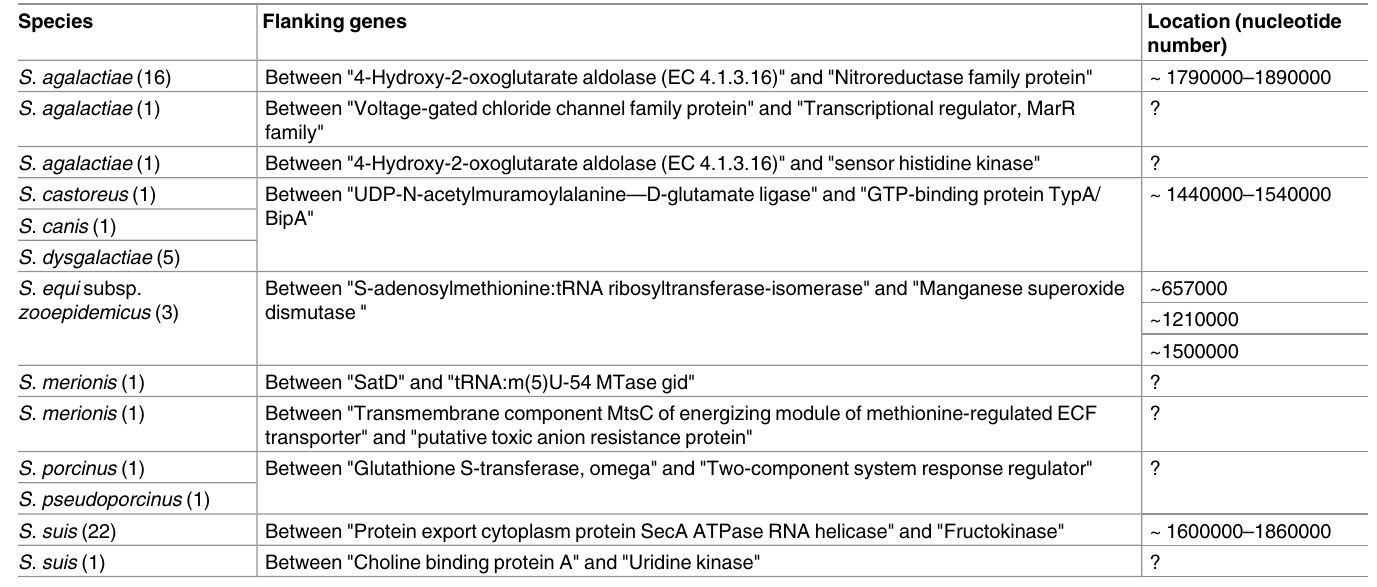
Table 4. Location of igdE genes within the genomes of the respective Streptococcus species and flanking genes. Species Flanking